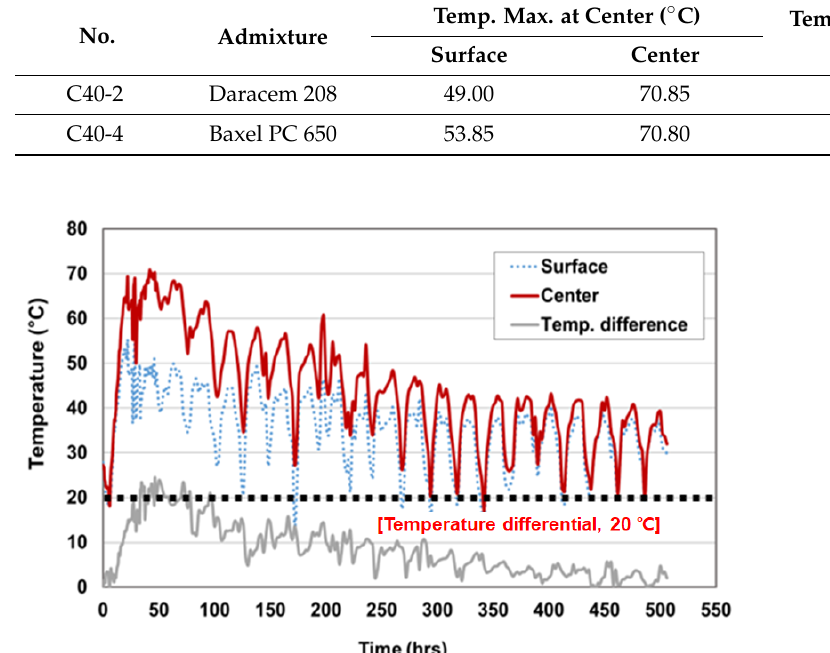
Figure 16. Cryogenic concrete with 65% GGBS and naphthalene type admixture.